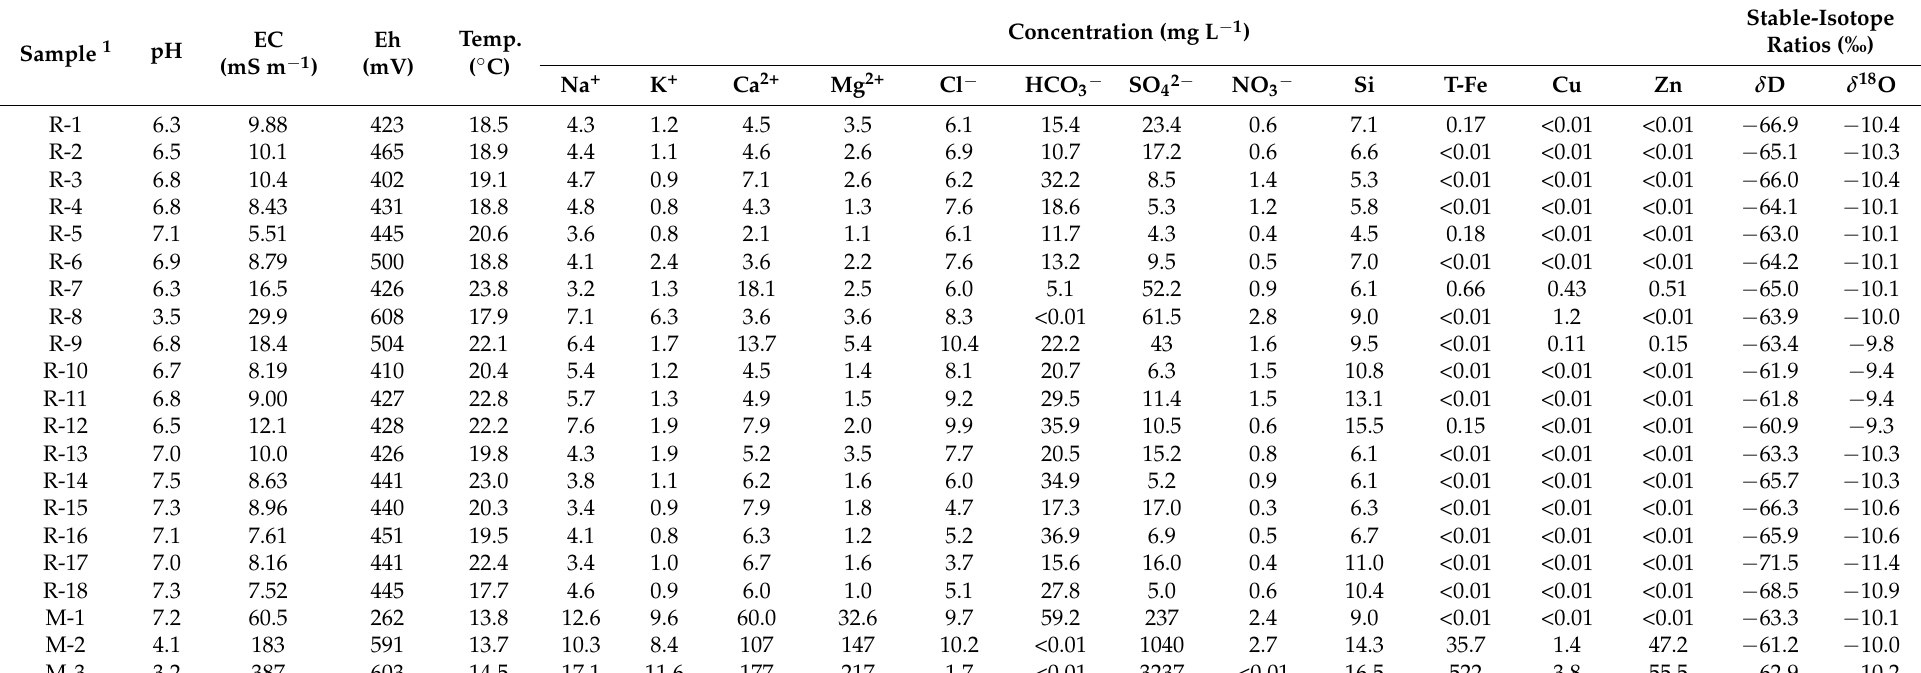
Table 1. Physicochemical properties of water samples collected during 4–6 September 2020.